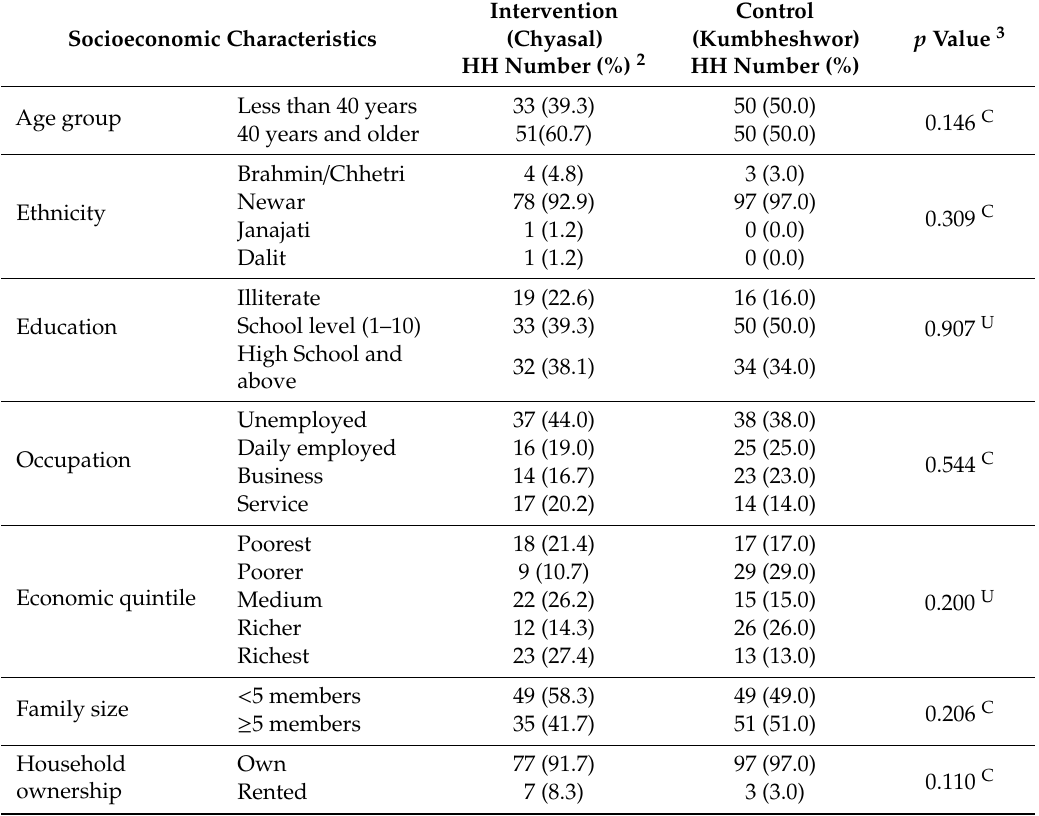
Table 1. Socioeconomic characteristics of the intervention and control sites and significance of the di ff erence 1